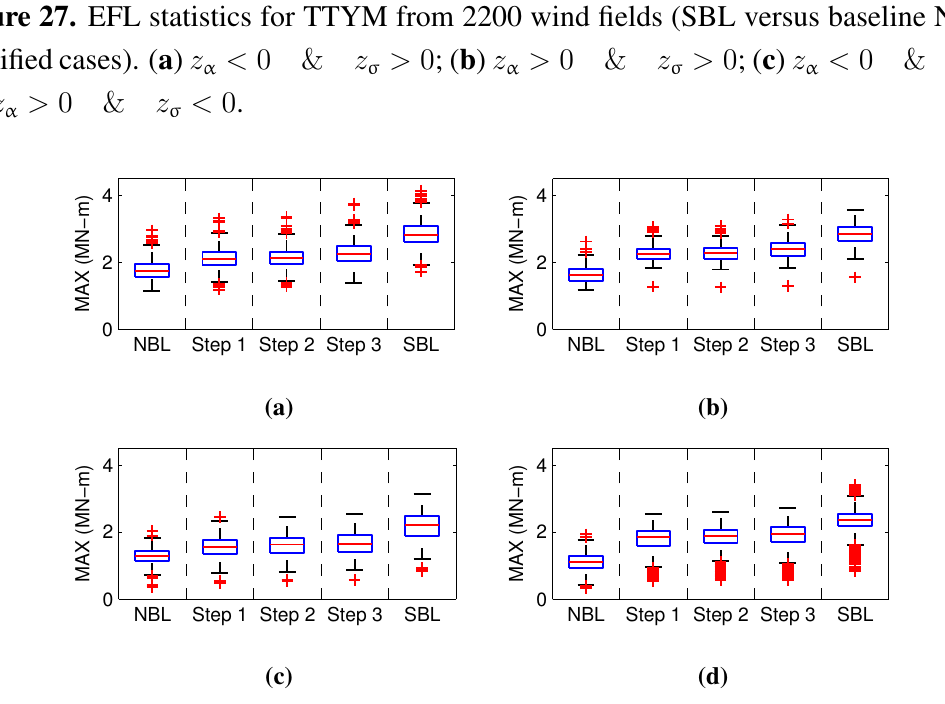
Figure 28. Ten-minute maximum statistics for TTYM from 2200 wind fields (SBL versus baseline NBL and modified cases). ( a ) z